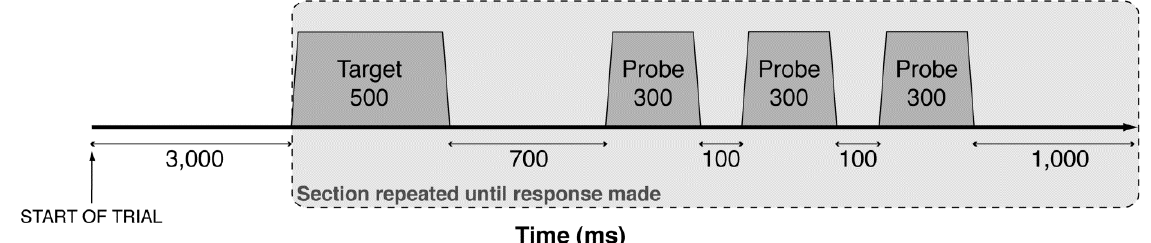
Figure 1. A schematic representation of the presentation of auditory stimuli. Each target stimulus and probe were synthesised with 30 ms linear onset and offset ramps and presented in a continuous sequence ( shaded box ) until participants matched the pitch of the probe to the target. Probes were synthesised in real-time at frequencies governed by participant movement of the computer mouse. Axis not shown to